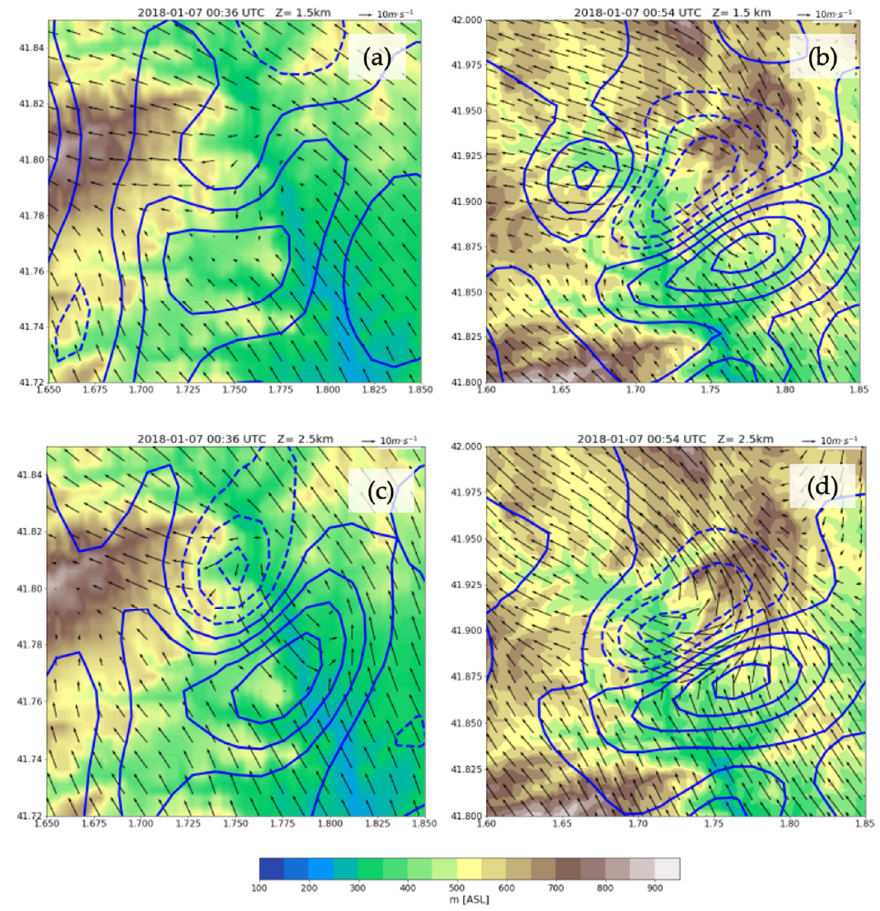
Figure 8. Retrieved SAMURAI fields for the supercell case on 7 January 2018 at 00:36 and 00:54 UTC. Storm-relative horizontal wind field (m · s − 1 , with black arrows) and vertical velocity ( w , every 3 m · s − 1 , with blue contours, dashed and solid for negative and positive values, respectively) at ( a , b ) Z = 1.5 km and ( c , d ) Z = 2.5 km.